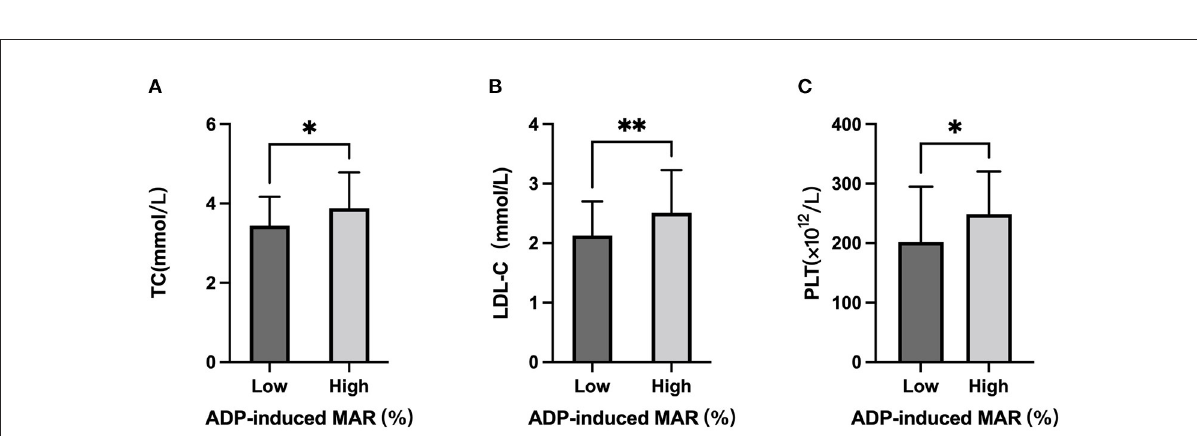
FIGURE4 TC, LDL-C, and PLT stratified by low and high ADP-induced platelet aggregation rate. Comparison of (A) Serum TC level, (B) serum LDL-C level, and (C) PLT in subjects with ADP-induced maximal platelet aggregation rate (MAR) lower and higher than mean value. *: P < 0.033, **: P < 0.002, ns: P >